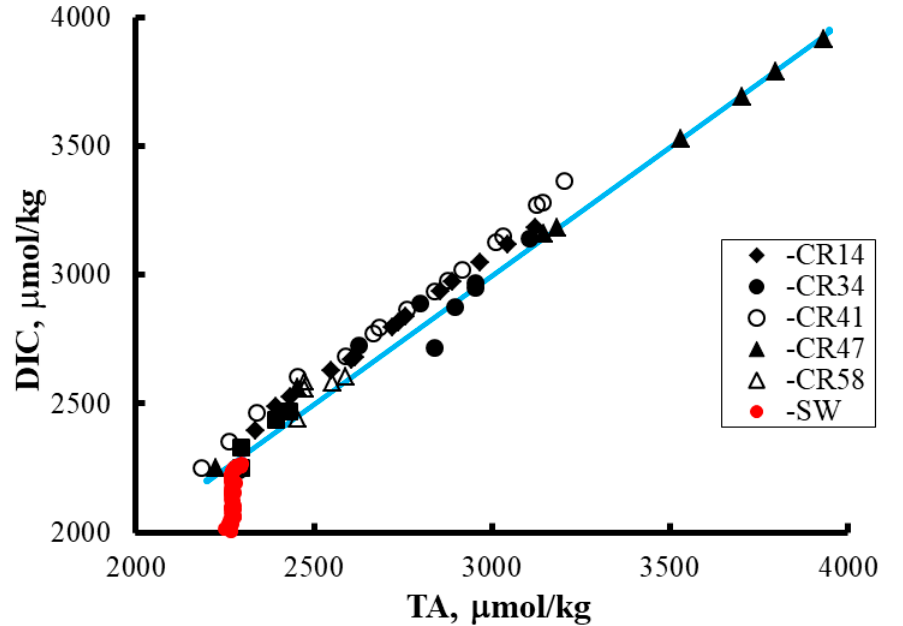
Figure 7. Relationship between DIC and TA in the sediments. The solid blue line was obtained using the least squares method. DIC ( µ mol/kg) = 56.2 + 0.9993 × TA; r 2 = 0.98, which closely corresponds to the theoretical relationship for the bacterial sulfate reduction that uses carbohydrates as the organic matter [33] when Δ DIC: Δ TA = 1. SW—measured TA and calculated DIC for the seawater column from all studied stations.